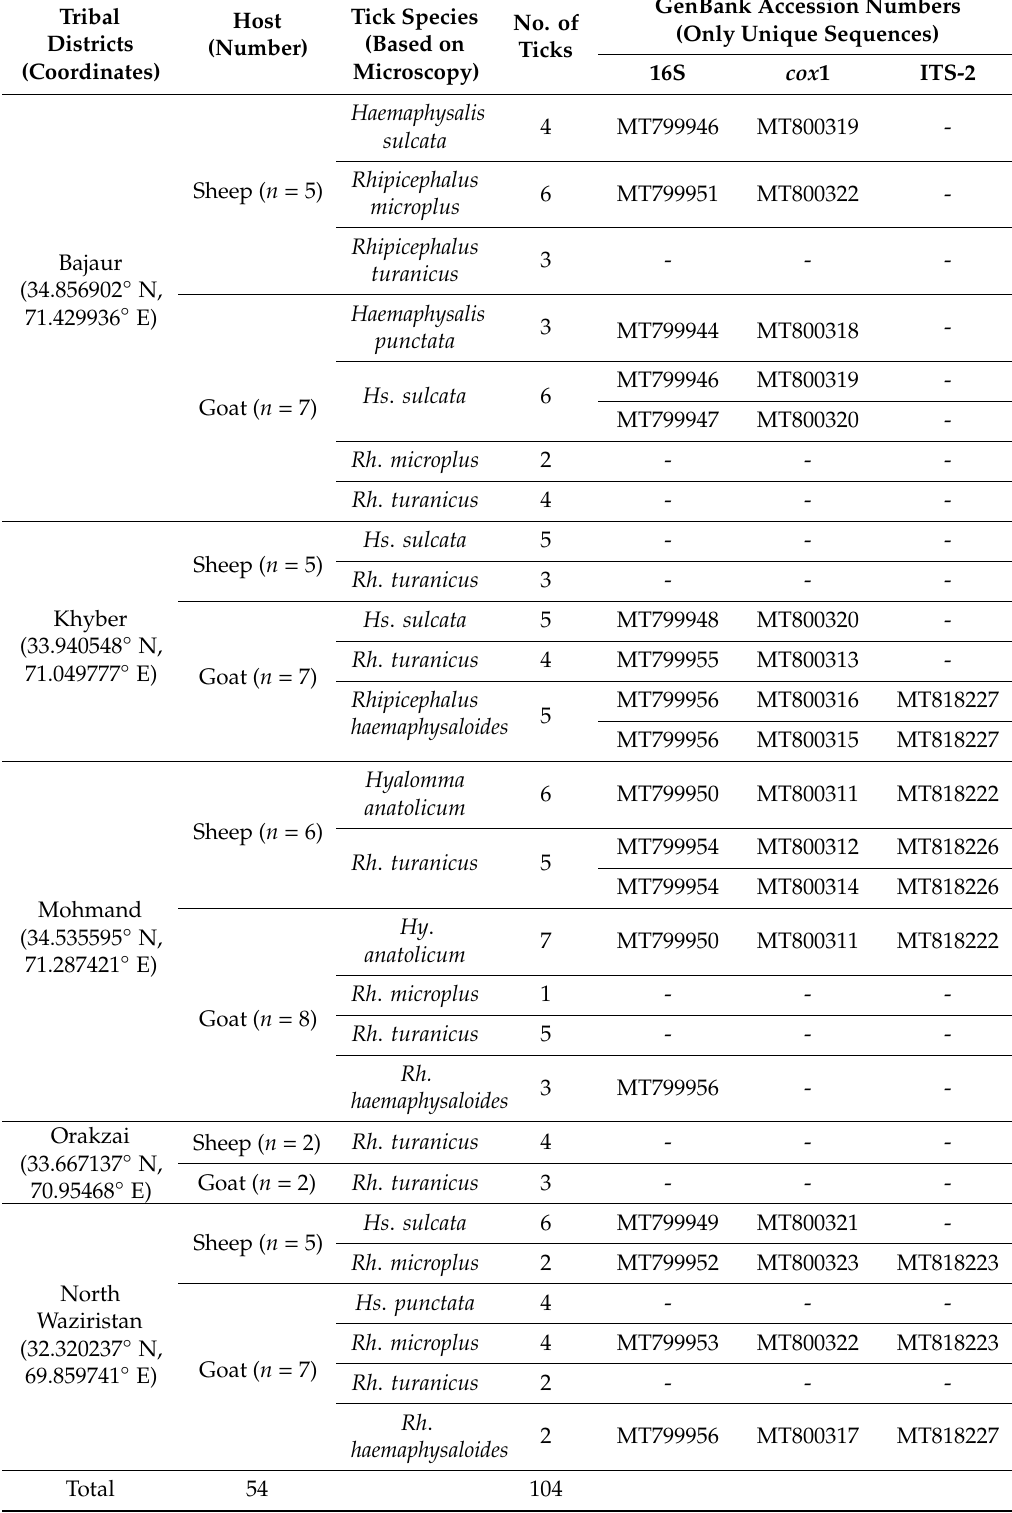
Table 1. Details of ticks of small ruminants from the FATA of Pakistan used in this study. GenBank accession numbers are also provided for unique 16S, cox 1 and ITS-2